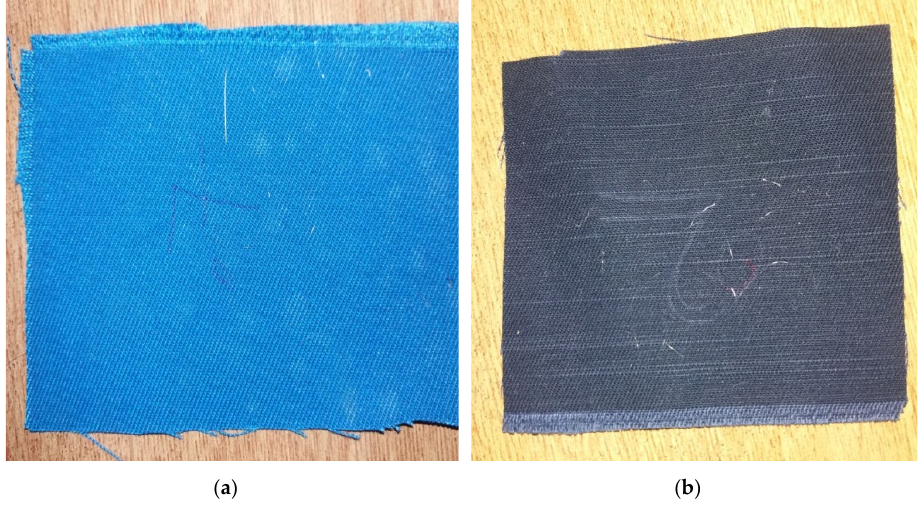
Figure 4. Specimens for yarn count test (horizontal direction is the warp direction), ( a ) TF7 specimen ( b ) TF2 specimen.